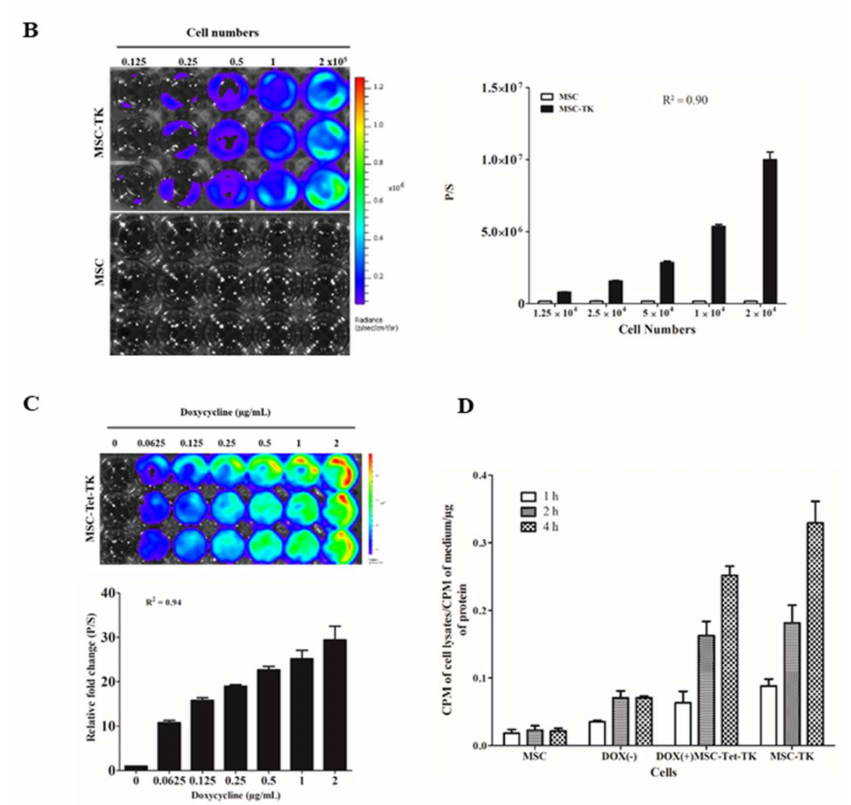
Figure 1. Transduction of mesenchymal stem cells (MSCs) with triple fusion (TF) reporter genes. ( A ) Enhanced green fluorescent protein (eGFP) confocal microscopy images of MSC-TK, MSC-Tet-TK plus DOX (2 µ g/mL, 24 h) or doxycycline( − ) (DOX( − )), and parental MSC cells. ( B ) Bioluminescent imaging (BLI) of Fluc activity in transduced MSC-TK cells at different cell densities. ( C ) Fluc activity of transduced MSCs (MSC-Tet-TK) after DOX treatment for 24 h assessed by bioluminescent imaging (BLI) and quantitation of this Fluc activity. ( D ) 3 H penciclovir (PCV) uptake assay. 3 H-Penciclovir (PCV) uptake of parental MSCs, DOX( − ) and DOX(+) MSC-Tet-TK, and MSC-TK cells for 1, 2, and 4 h. p/s,